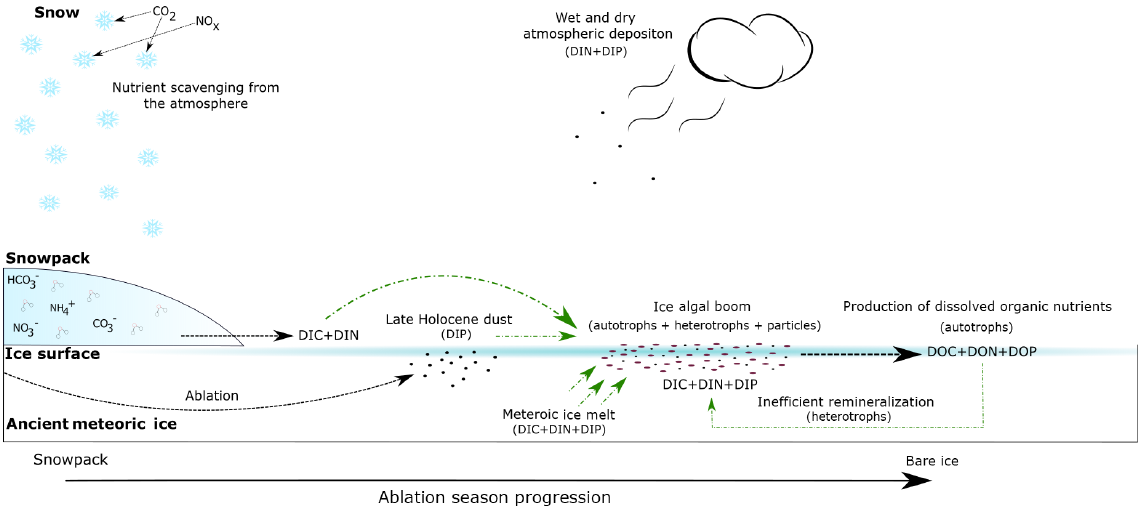
Figure 7. Conceptual diagram of the supraglacial environment in the Dark Zone of the GrIS. Black dashed lines represent nutrient inputs to all supraglacial environments. Green lines represent hypothesized nutrient inputs utilized by ice algal blooms. Arrow thickness represents relative nutrient